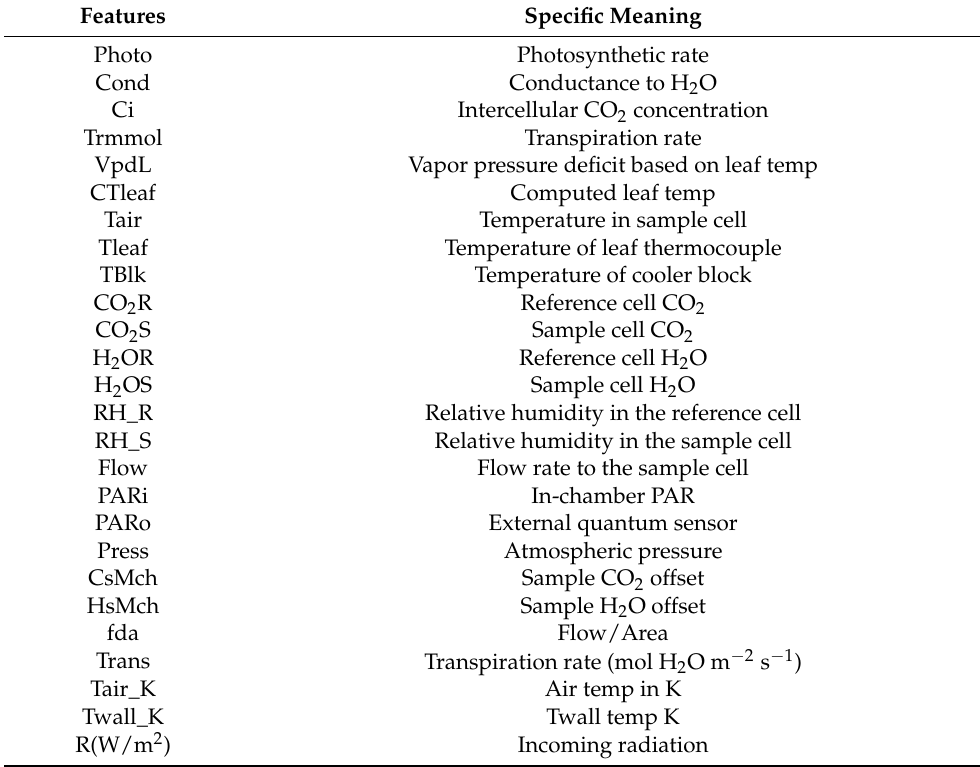
Figure A1. Regression results of four multiple linear regression methods on training set and test set. ( a ) Training set; ( b ) test set; ( c ) comparison between training set and test set. Table A1. The specific meanings and correlation coefficients of 41 features.